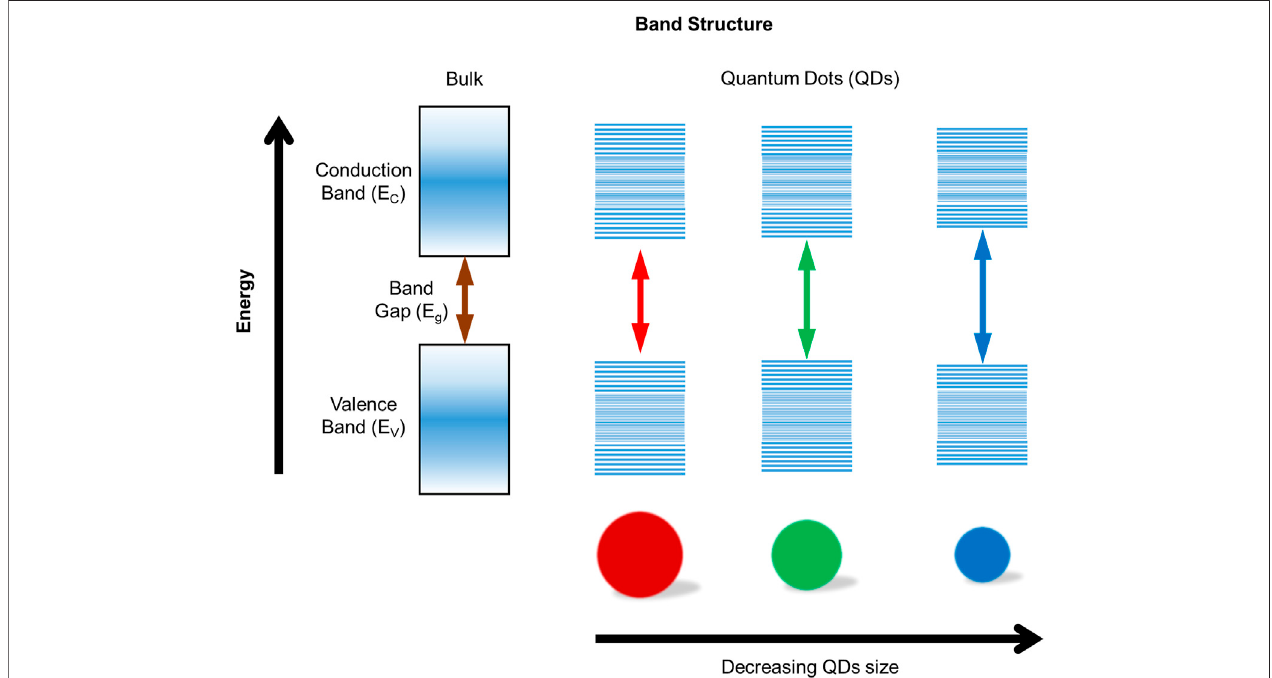
FIGURE 1 | Electronic structures of inorganic semiconductors of bulk material, QDs of different diameters.